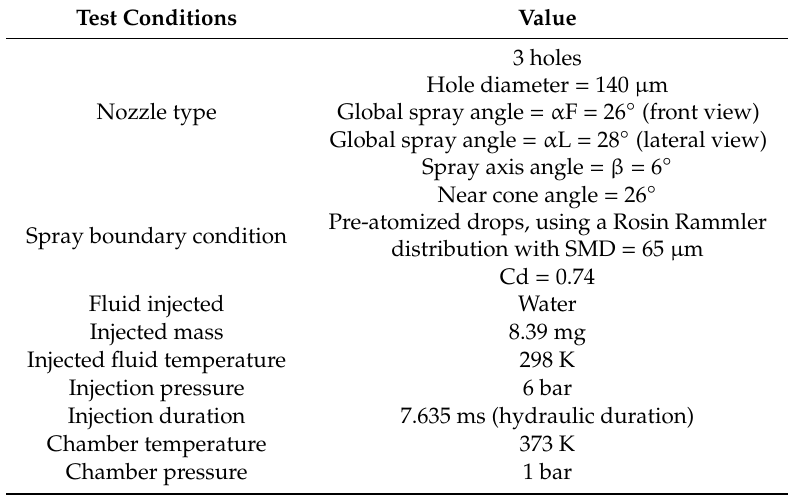
Table 3. Water Injector and vessel test conditions for 6 bar inj. pressure